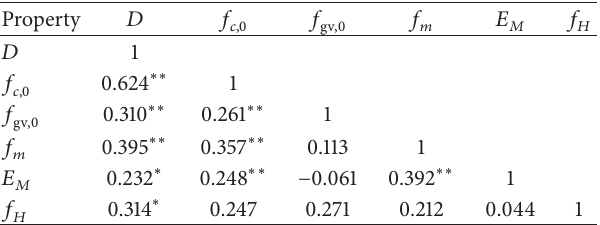
Table 6: Pearson correlation ( 𝑟 ) for properties versus apparent